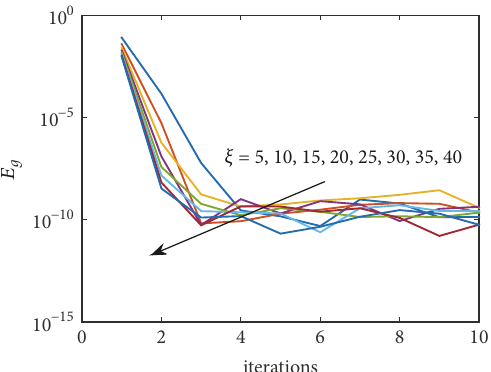
Figure 7: Convergence error graph of 𝑔(𝜁,𝜉) at different values of 𝜁 , 𝑁 𝜂 = 60 , 𝑁 𝜁 = 5 , 𝑛 = 𝑤 = 1/2 , 𝑃𝑟 = 0.7 , 𝑆𝑐 = 0.6 , and 𝑧 = 40 .